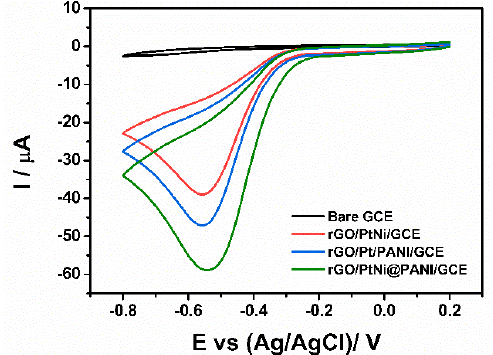
Figure 7. CVs of bare GCE, rGO/PtNi/GCE, rGO/Pt/PANI/GCE, and rGO/PANI@PtNi/GCE in N 2 -saturated 0.2 M phosphate bu ff ered saline (PBS) at pH: 6.5 in the presence of 0.1 mM H 2 O 2 N 2 -saturated 0.2 M phosphate buffered saline (PBS) at pH: 6.5 in the presence of 0.1 mM H 2 O 2 (scan (scan rate: 50 mV / rate: 50 mV/s).